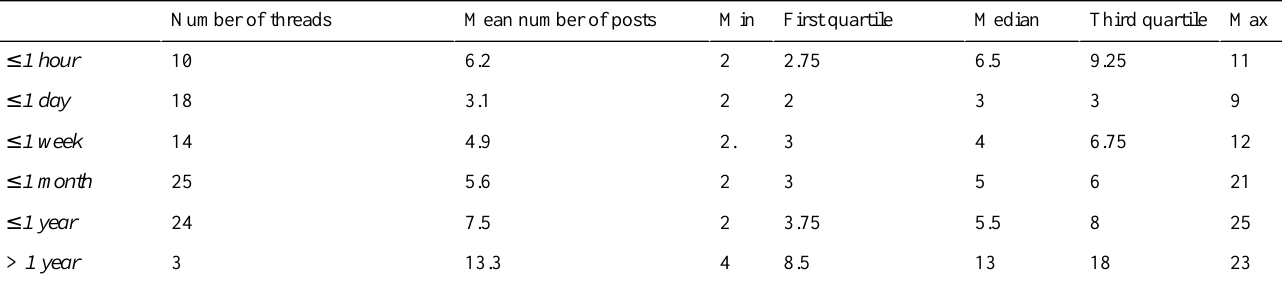
Table 1. The number of posts per thread for each of the thread duration